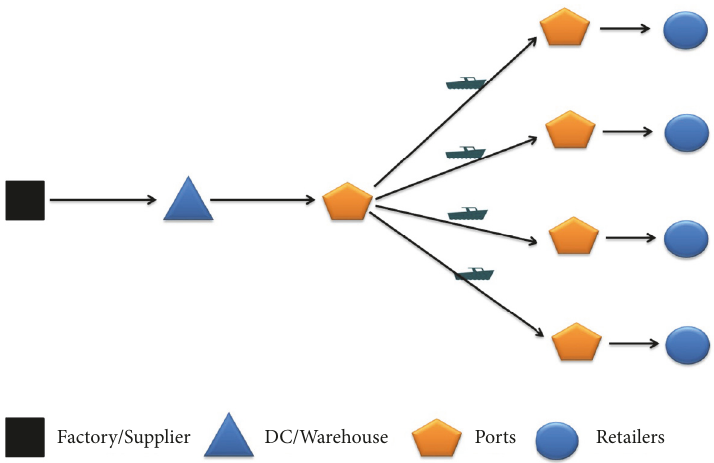
Figure 1: A distribution system with one DC, a set of ports, and a set of